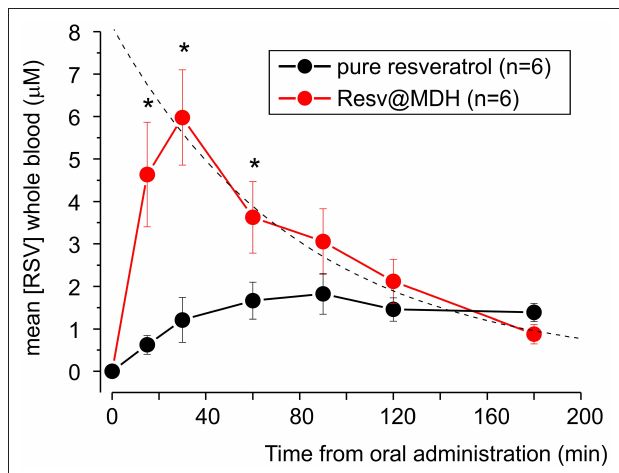
FIGURE 5 | Mean plasma concentration-time curve for free plasmatic resveratrol ( n = 6) after treatment with of either 180mg pure resveratrol (Polygonum cuspidatum 98%) or 180mg resveratrol from Resv@MDH obtained from subjects displayed in Figure 4 . The dash line represents the best fit of the experimental data point of resveratrol blood concentration following Resv@MDH administration by a mono-exponential model (for details see text in Results section). The black and red dots indicate the resveratrol plasma concentration from the administration of pure resveratrol and Resv@MDH, respectively. * p < 0.05.